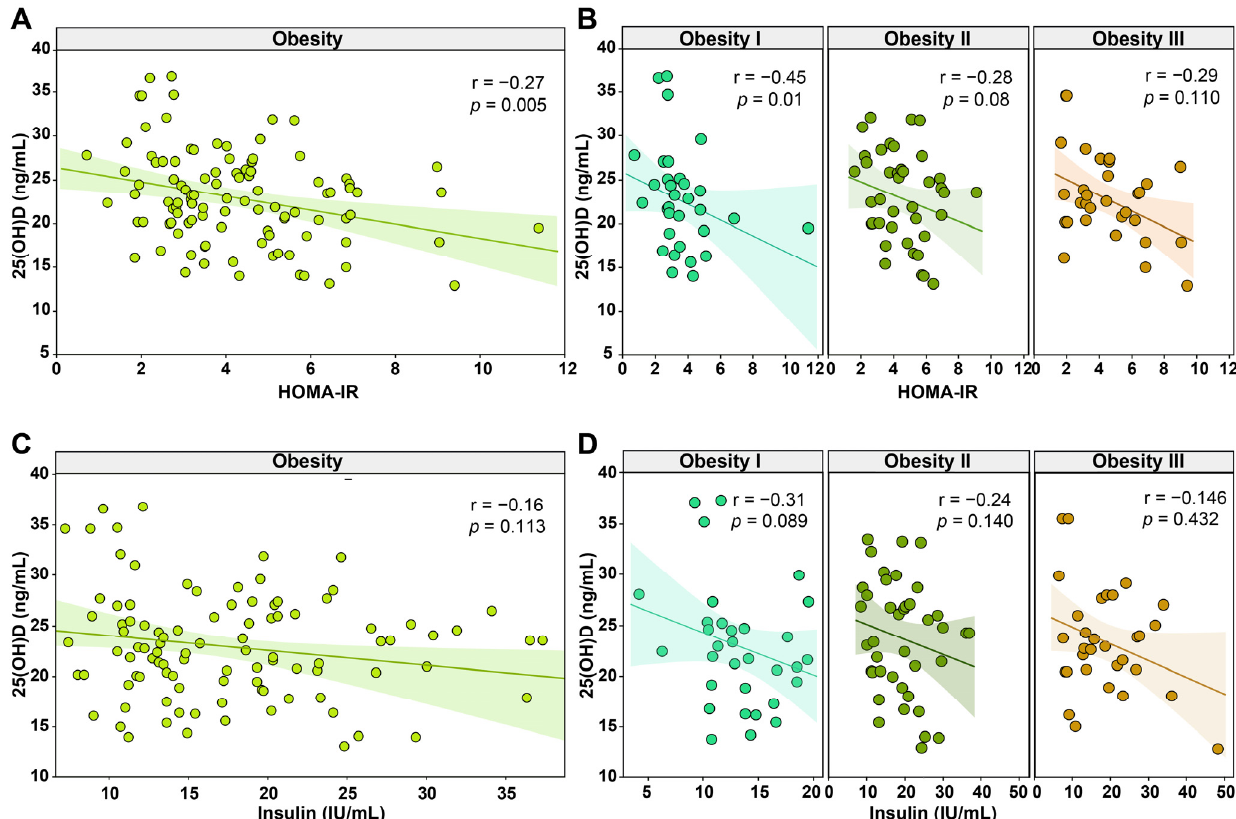
Figure 1. Spearman correlation analysis of the 25 ‐ hydroxyvitamin D [25(OH)D] shows association with HOMA ‐ IR and insulin in women with obesity. ( A ) Correlation plot between 25 ‐ hydroxyvitamin D and HOMA ‐ IR. ( B ) Correlation plot between 25 ‐ hydroxyvitamin D and HOMA ‐ IR by obesity class. ( C ) Correlation plot between 25 ‐ hydroxyvitamin D and Insulin. ( D ) Correlation plot between 25 ‐ hydroxyvitamin D and insulin by obesity class. Abbreviations: 25(OH)D = 25 ‐ hydroxyvitamin D; HOMA ‐ IR = homeostatic model assessment ‐ insulin resistance; IU = international unit; mL = microliter.